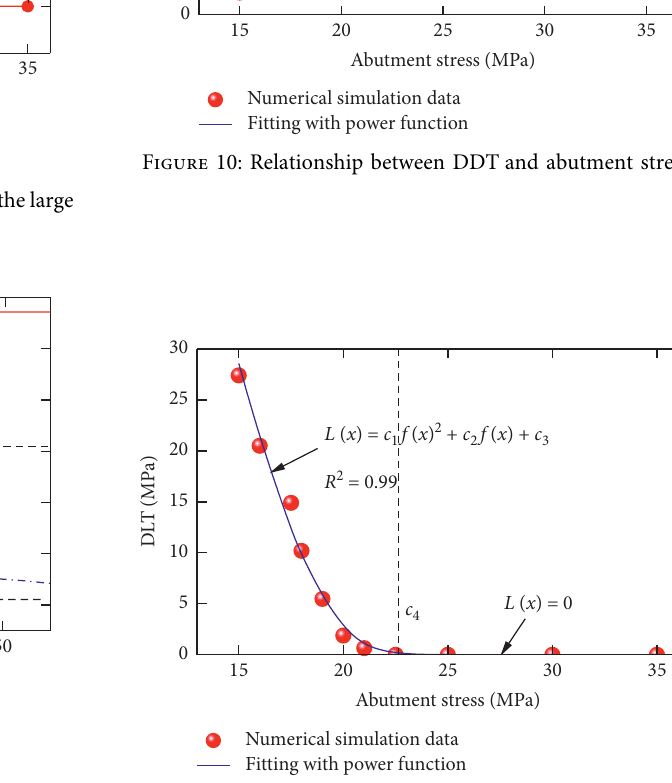
Figure 11: Relationship between DLT and abutment